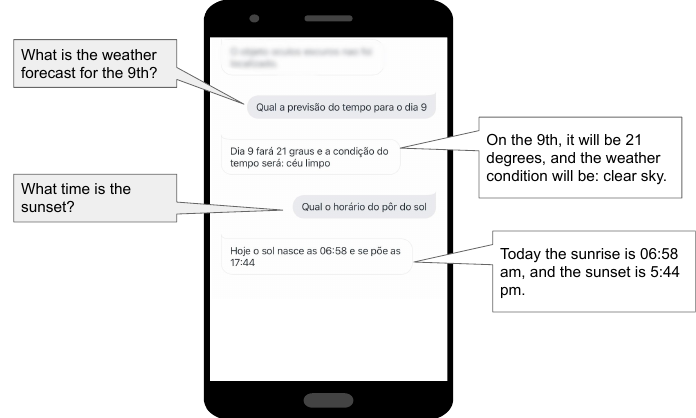
Figure 8. Homer execution—entertainment for solitude.